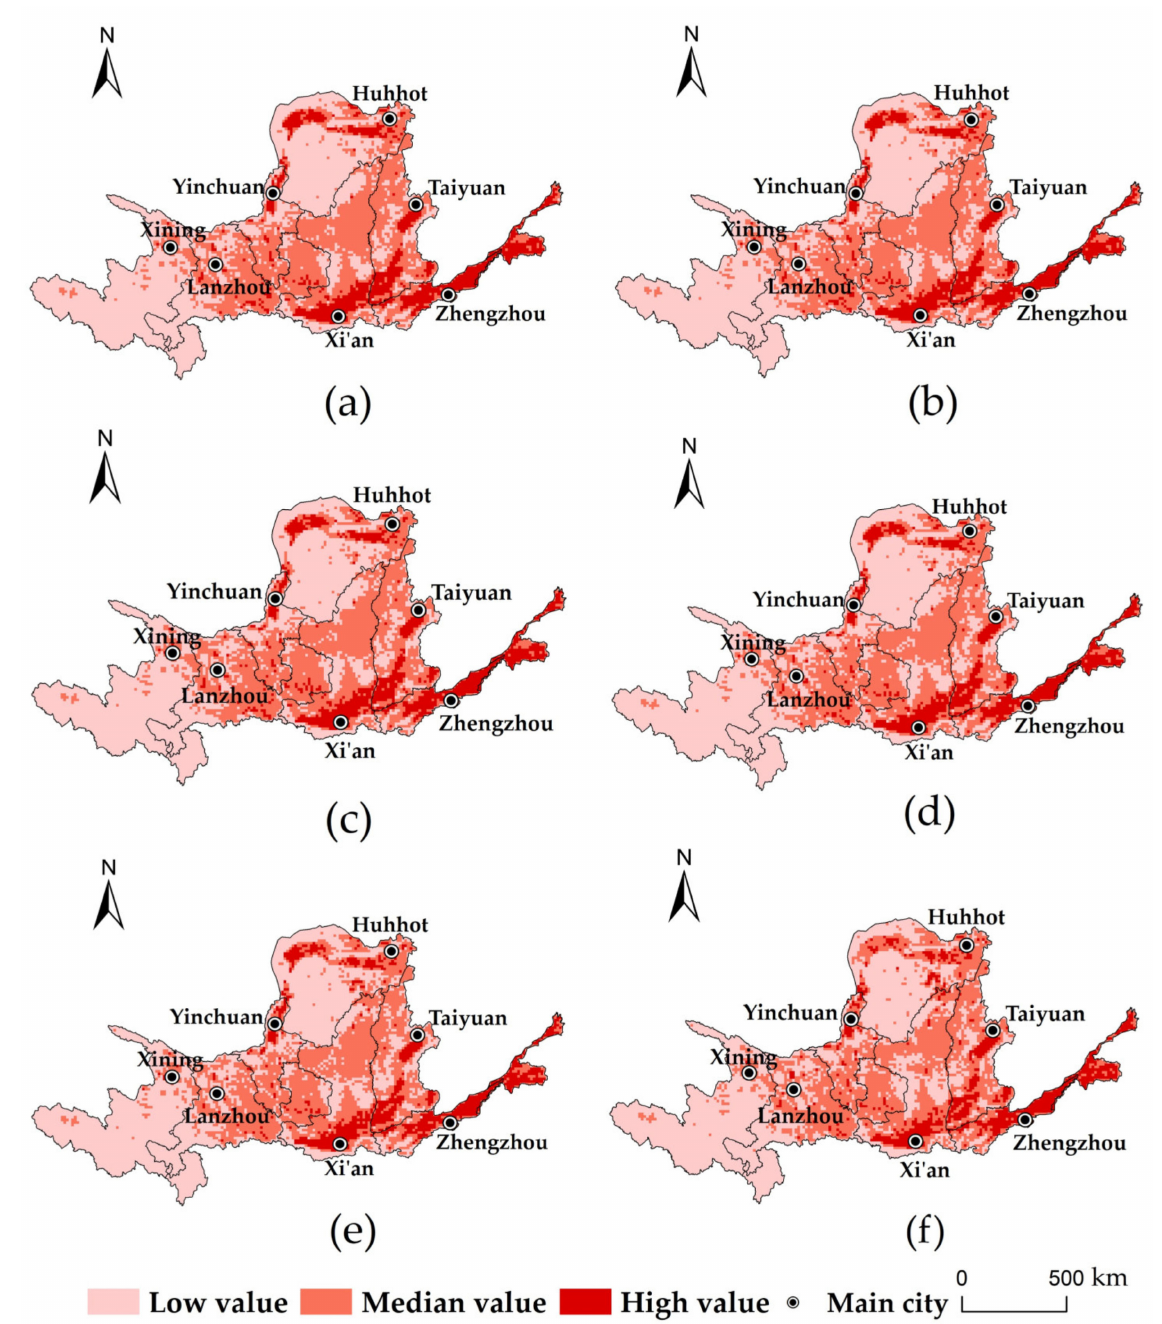
Figure 5. Spatial distribution of economic benefits of land use in the Yellow River Basin: ( a ) 1995; ( b ) 2000; ( c ) 2005; ( d ) 2010; ( e ) 2015; ( f )